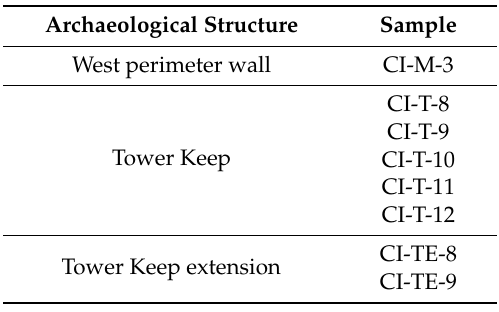
Table 1. Studied samples from different structures at Irulegi